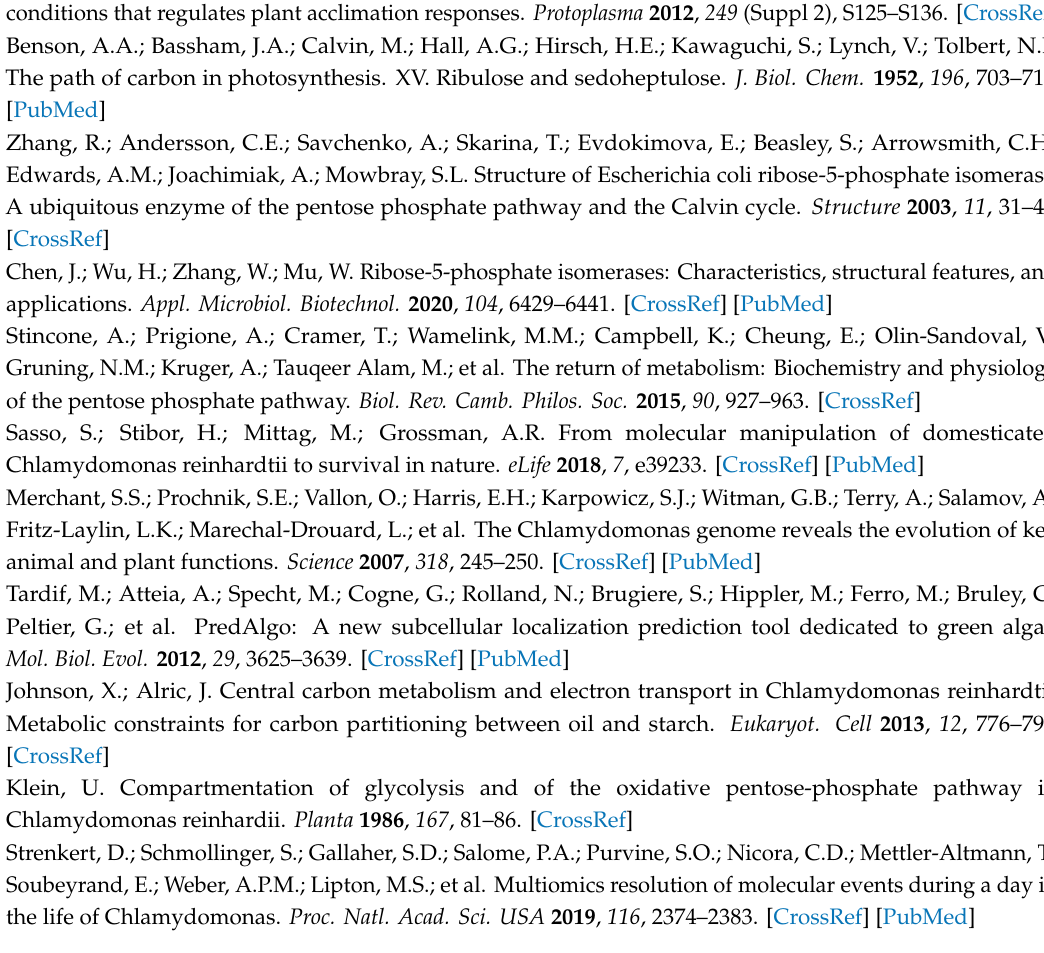
represented as sticks. Other residues of CrRPI1 and LpRPI are respectively colored in blue and green. Sulfate ion and Ribose-5-phosphate are represented in sticks, water molecules and Na ion are represented in spheres. (B) Structure of CrRPI1. (C) Structure of LpRPI. Figure S3. (A) CrRPI1 post-translational modifications sites. Residues of the catalytic cleft are colored in orange. Cysteines and residues found phosphorylated in Wang, Gau et al. are represented in sticks and respectively colored in red and blue. (B) Connolly solvent exclusion surface of the same view as A. and same color